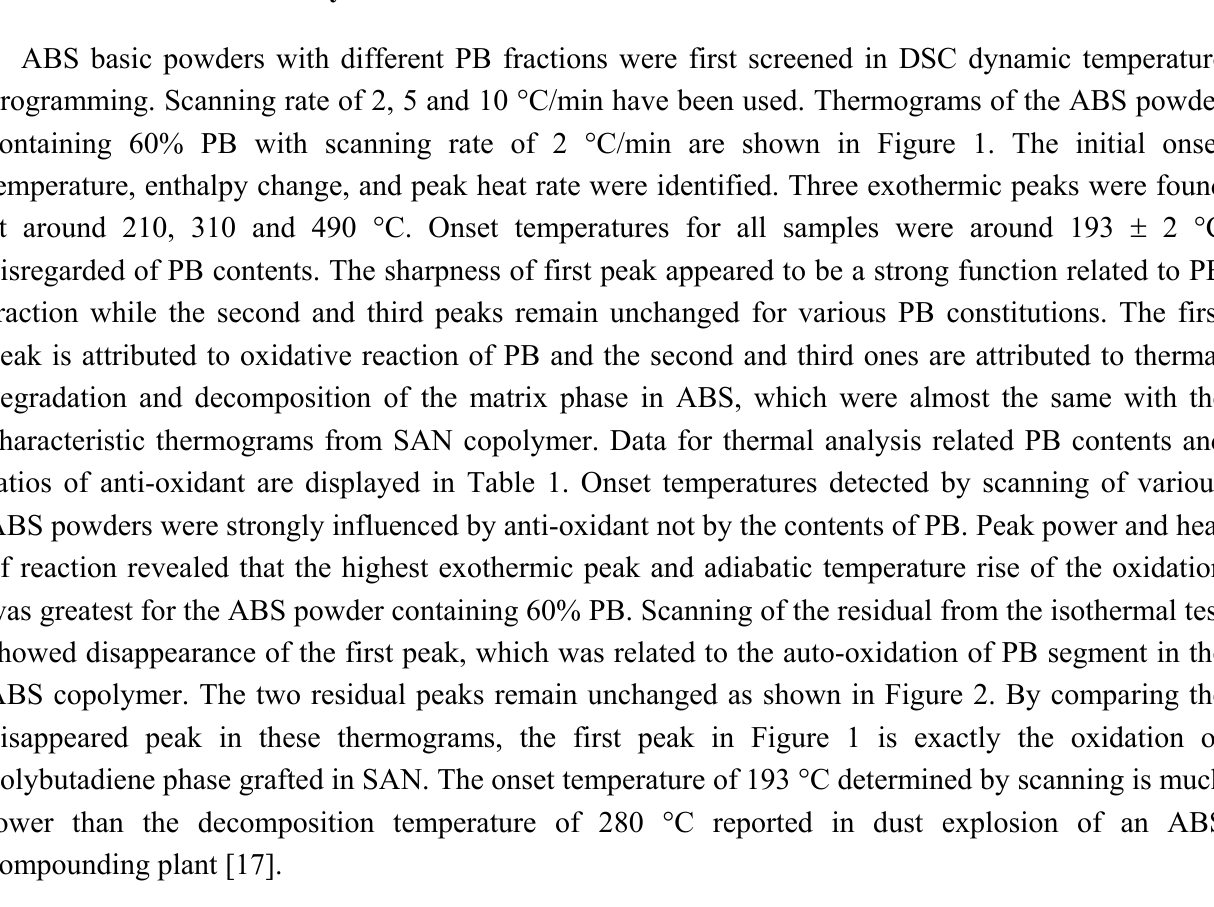
Figure 1. Dynamic DSC thermograms for ABS powders containing 60%